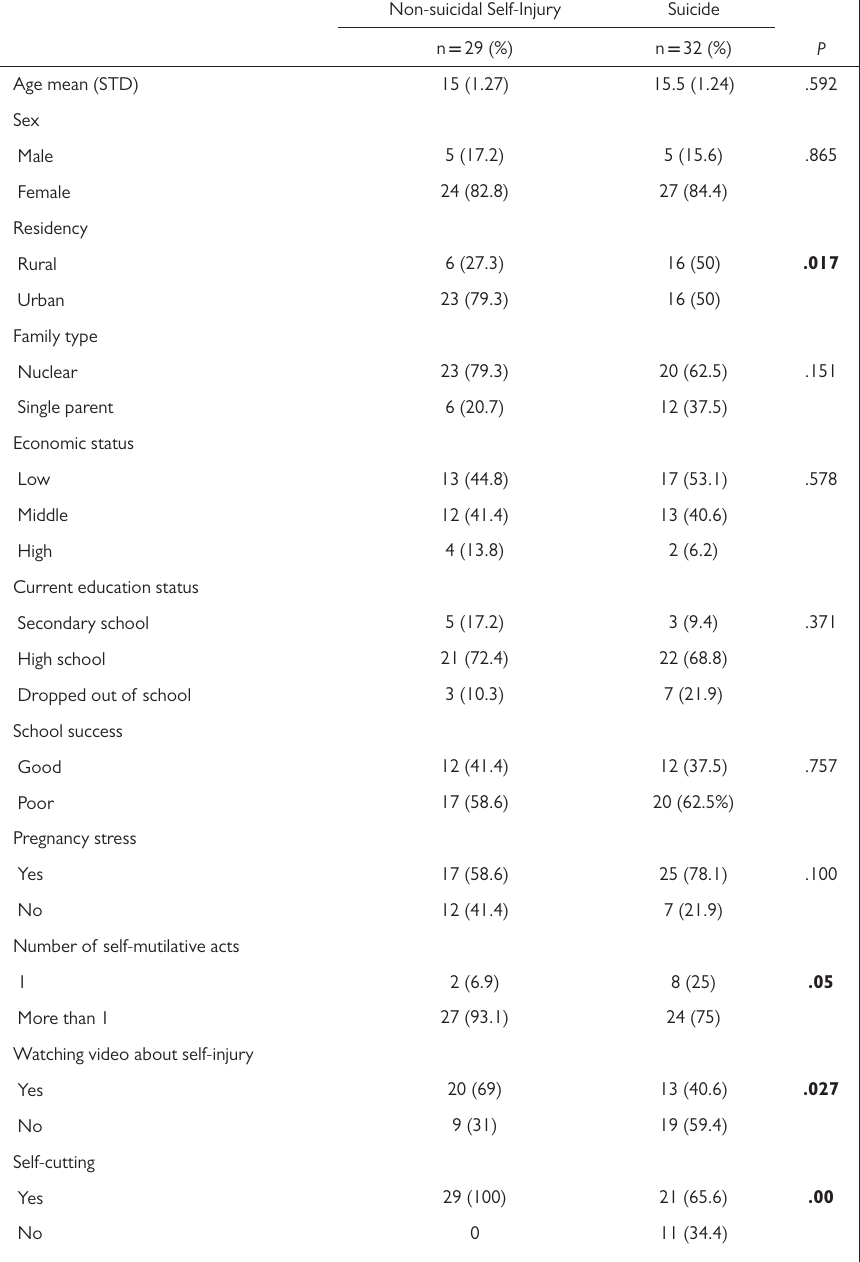
Table 1. Demographic